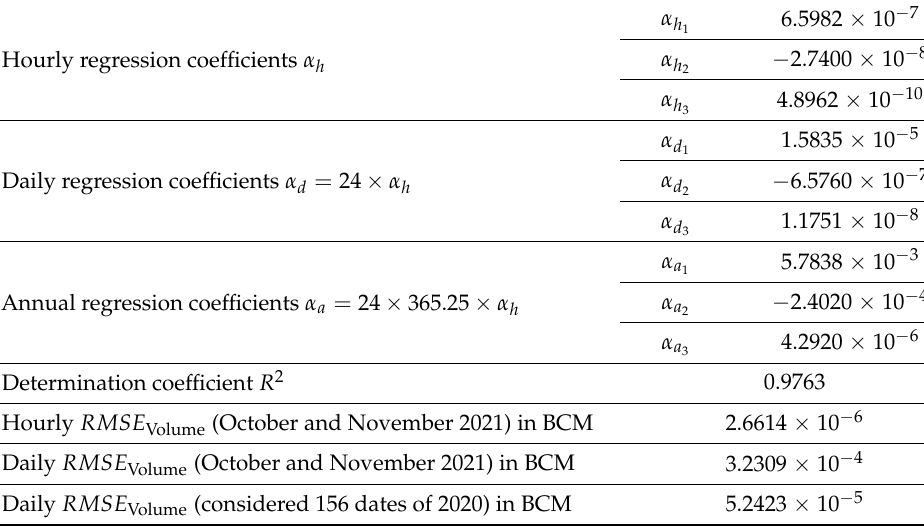
Table 5. Obtained results by means of the established intercepting a zero “third-order” polynomial regression model using the two months of October and November 2021.